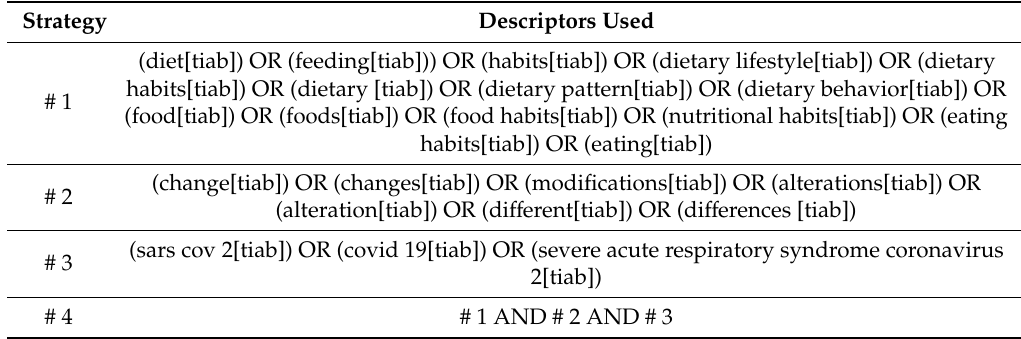
Table 1. Search strategy used in the US National Library of Medicine (PubMed) and Medical Literature Analysis and Retrieval System Online (MEDLINE), according to the selected